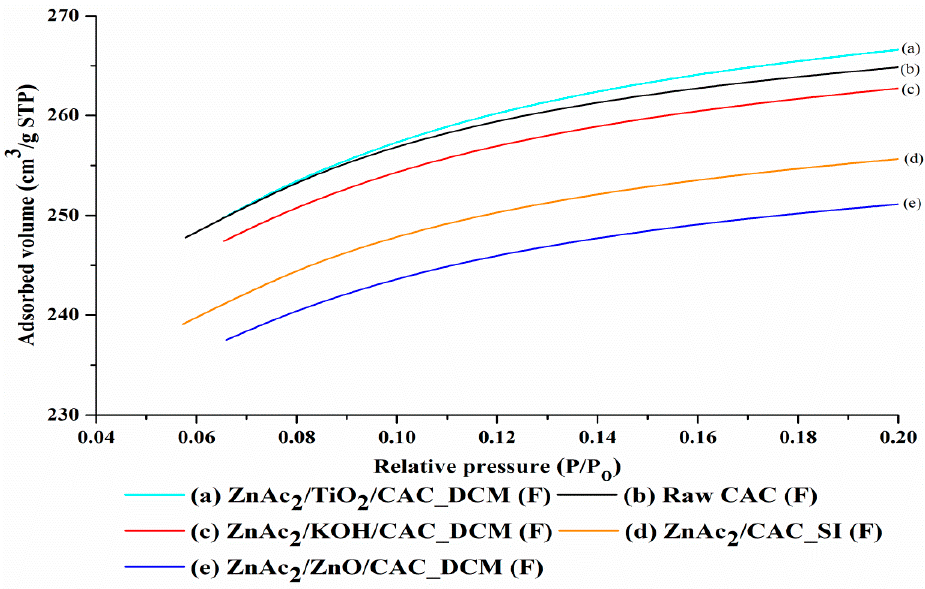
Figure 3. N 2 adsorption isotherm curves for fresh DCM/CAC, SI/CAC and raw CAC adsorbents.